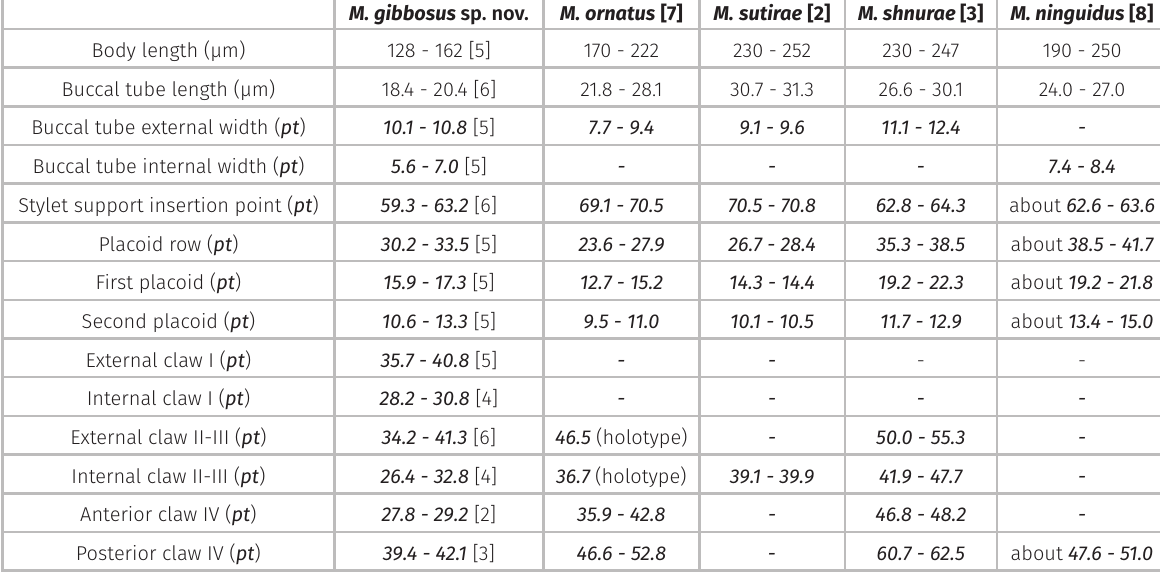
Table IV. Morphometric comparison of Mixibius gibbosus sp. nov. with the most similar species. The numbers in brackets indicate how many specimens were measured. For correct comparison with some past species, claw measurements refer to the entire claw, and the values relative to claws II and III are joined together. The pt index ranges about Mix. ninguidus were calculated from Biserov (1999, Table 3). The pt index is the ratio of the length of a given structure to the length of the buccal tube, expressed as a percentage (Pilato 1981). M. gibbosus sp.